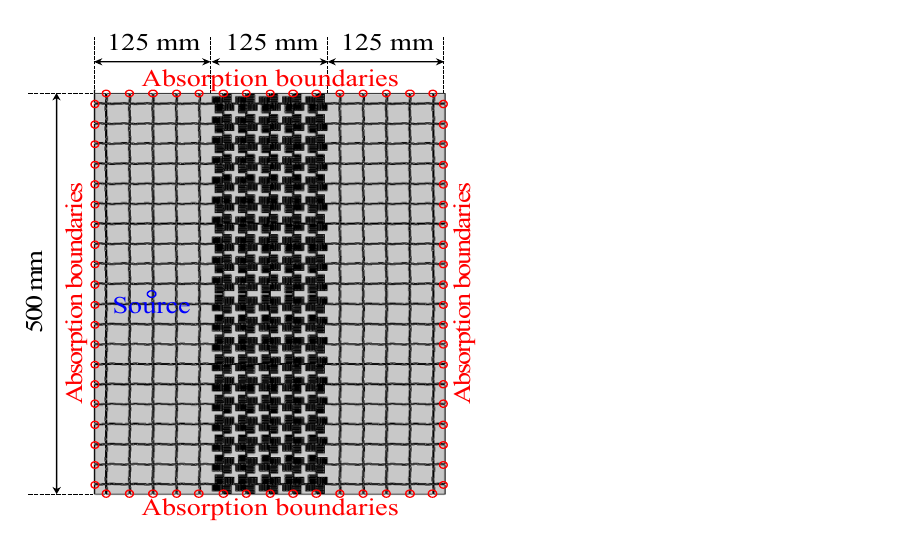
Figure 6. The setup for the full-wave simulation for the designed NRI acoustic lens ( ∆ d B = ∆ d NRI = 25 mm). The size of the background medium and the lens are 20 ∆ d NRI × 5 ∆ d NRI = 500 mm × 125 mm, and are composed of the structures in Figure 5a,b, respectively. An acoustic wave source is placed at the position where it is separated by d 1 /2 = d 2 /2 = 2.5 ∆ d NRI = 62.5 mm from the lens.